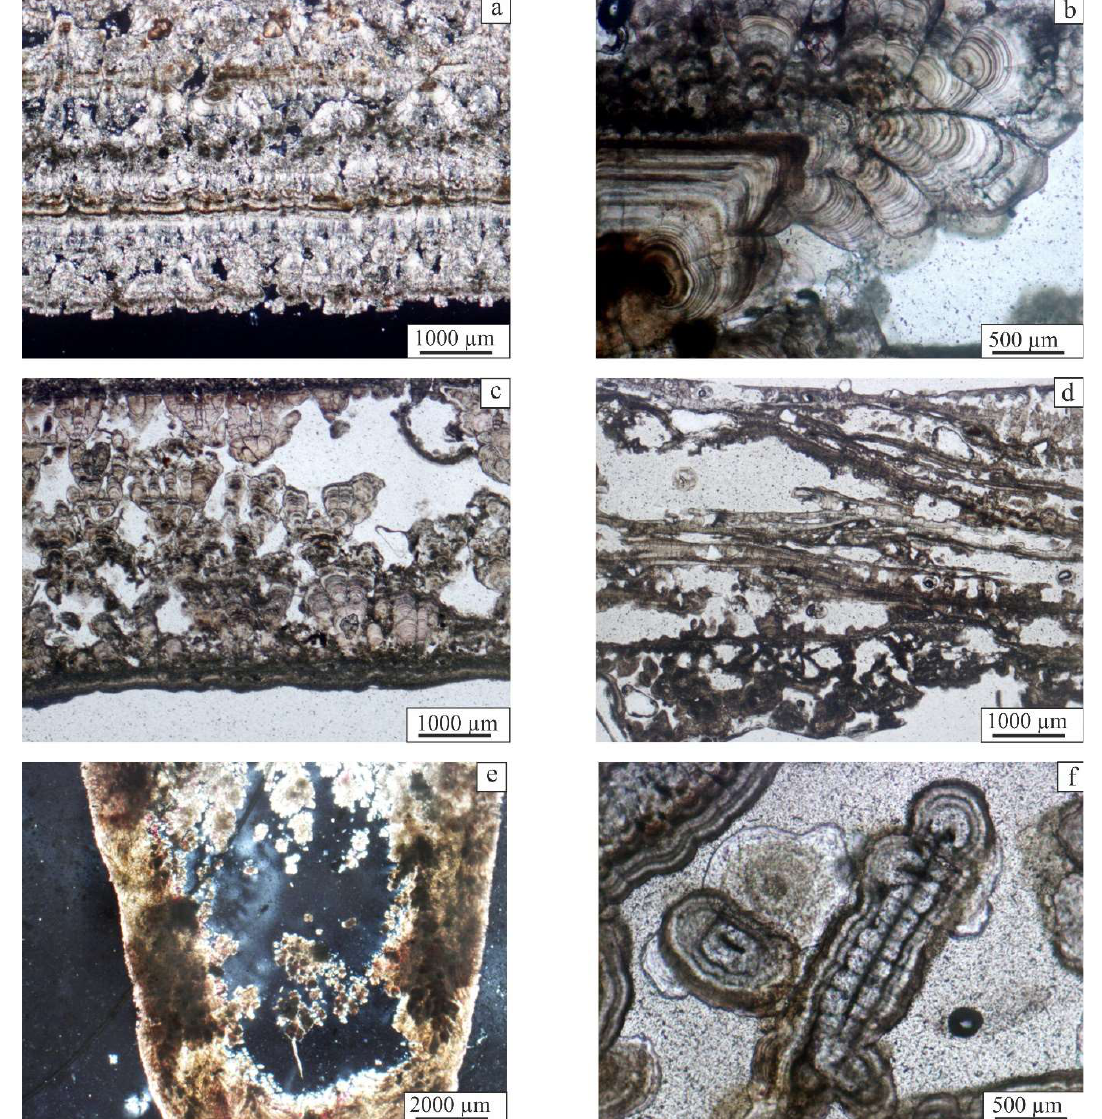
Figure 3. Features of the microstructure of the carbonate neoformations on the facades of buildings and engineering structures of Tyumen: ( a ) crusts developing on the vertical surfaces of the second level of the Tura embankment (XPL); ( b ) massive crusts that develop on the horizontal surfaces of the second level of the Tura embankment (PPL); ( c ) crusts at the upper level embankment of the Tura River (PPL); ( d ) crusts on the facades of the Department of Mineral Resources and Ecology of the Tyumen Region (PPL); ( e ) differences in the external and internal surfaces of the stalactite-like neoformations of the second level of the Tura River Embankment (XPL); and ( f ) aggregates that are likely to develop over the hypha of the fungus and have a biogenic origin (PPL).